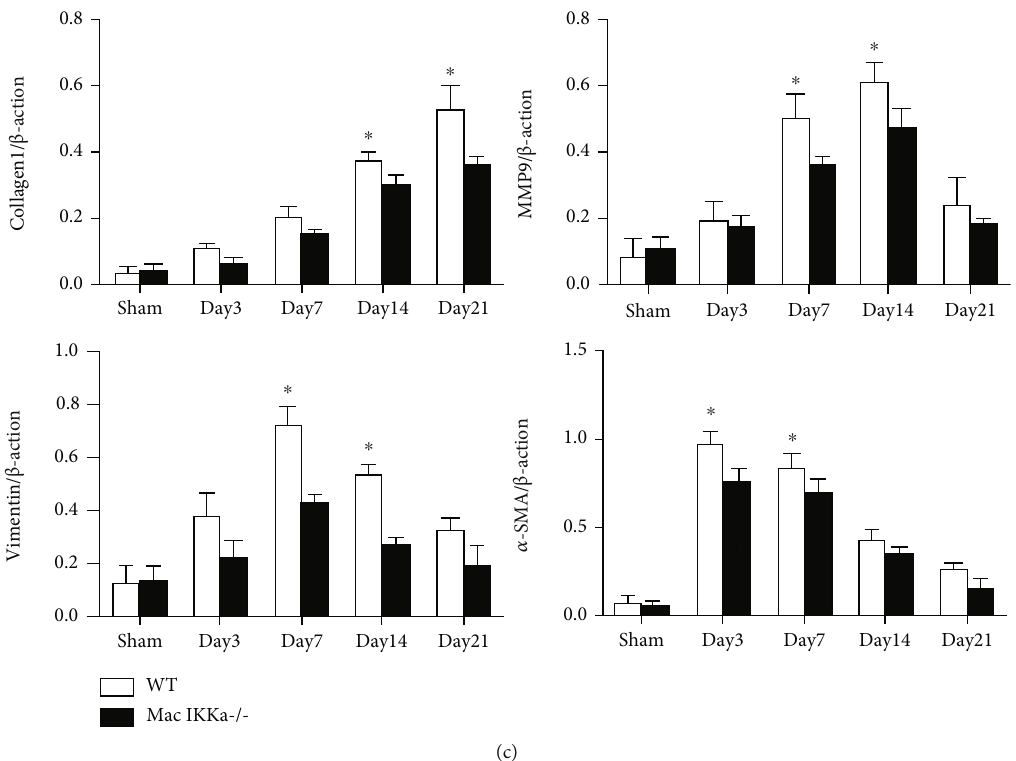
Figure 3: Renal histological changes shown by hematoxylin and eosin staining (H&E) and the expression of proteins that indicate renal fi brosis. (a) Representative images of H&E-stained kidney sections from sham-treated and IRI mice at the indicated time points. Mac IKK α − / − mice exhibited a lesser degree of tubular injury than WT mice. Scale bar = 50 μ m; magni fi cation, × 400. (b) Representative images of Western blotting for collagen I, MMP9, vimentin, and α -SMA in sham kidneys and IRI kidneys at the indicated time points. (c) Expression levels of collagen I, MMP9, vimentin, and α -SMA in the kidneys after normalization to β -actin as loading controls. Data are presented as the mean ± s : d . ∗ P < 0 : 05 versus Mac IKK α − / − mice; n = 4 , two-way